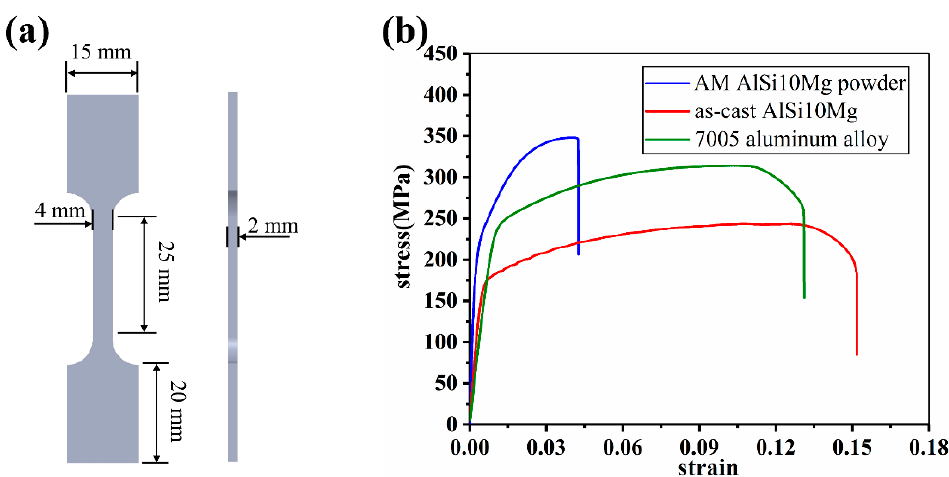
Figure 1. The tensile test of different aluminum alloys, ( a ) is the geometric dimensions of tensile sample; ( b ) is the stress–strain curves.